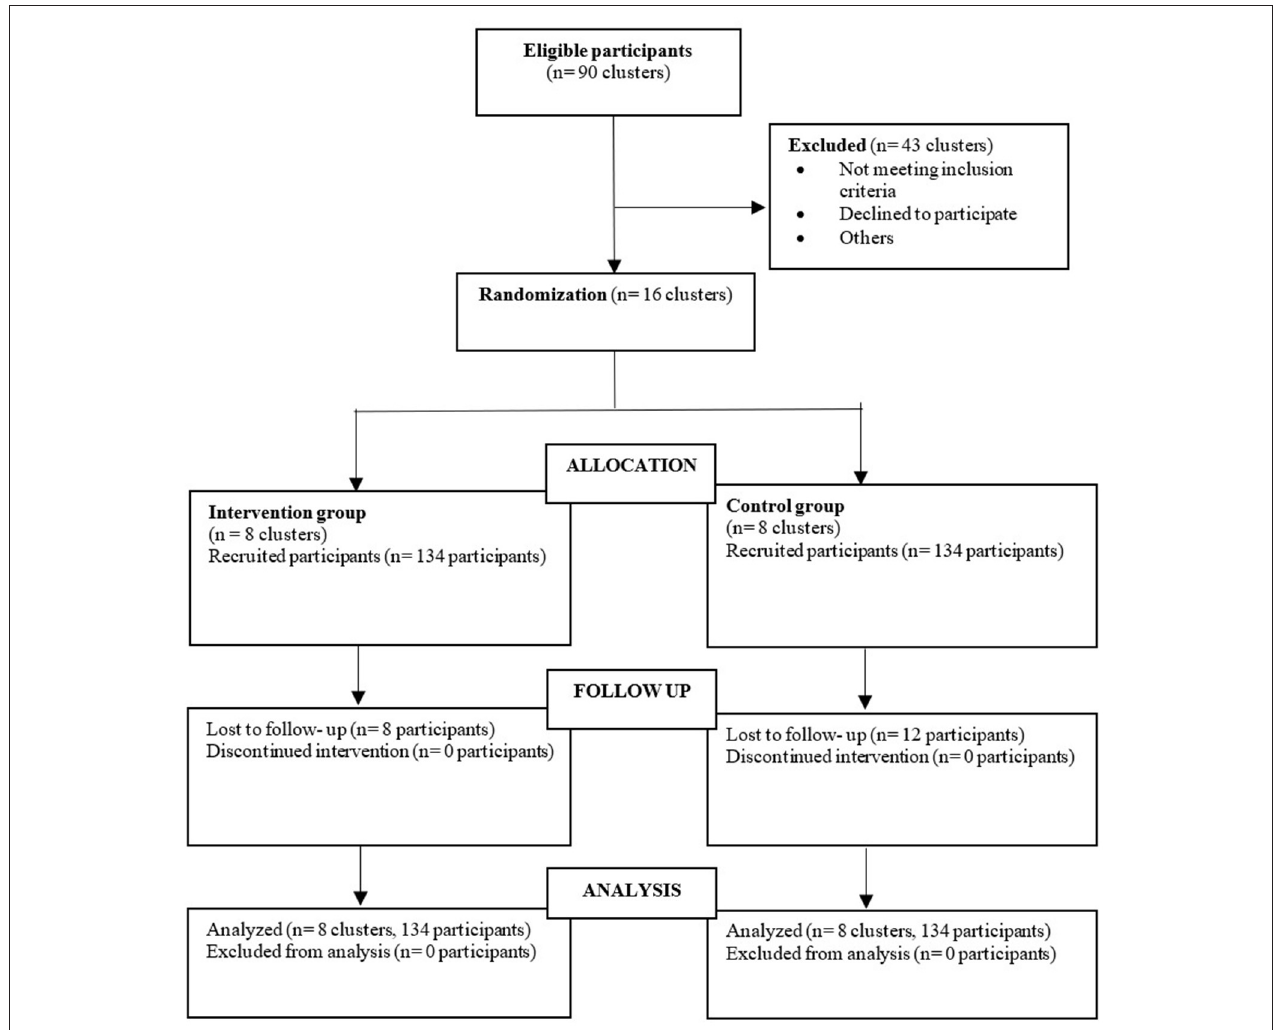
FIGURE 2 | CONSORT flow